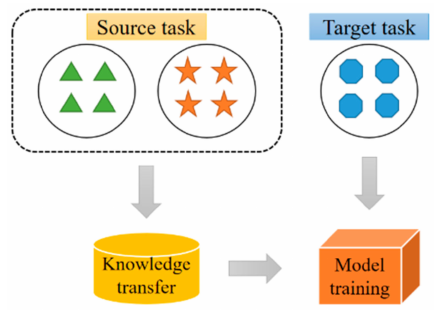
Figure 2. Transfer